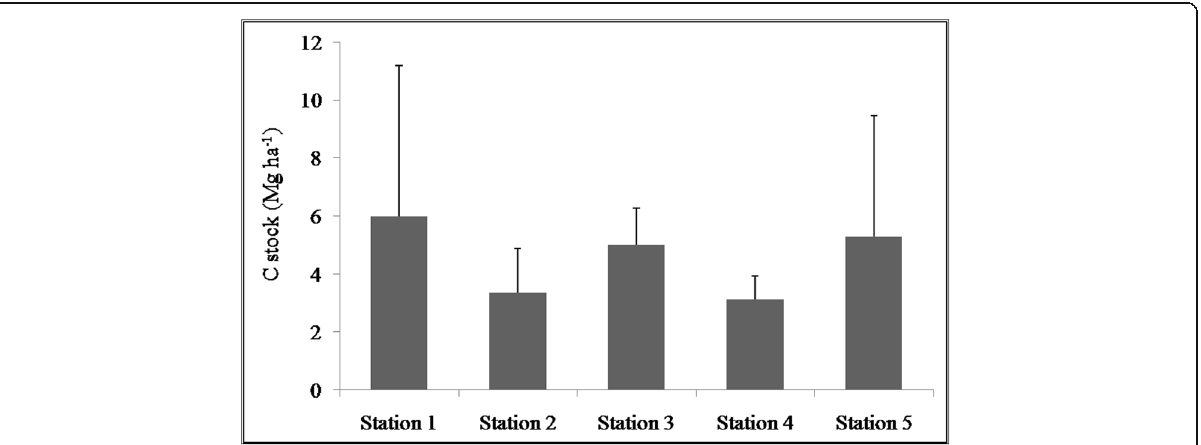
Fig. 6 Carbon stock (Mg ha − 1 ) of wetland vegetation across the different sampling stations namely station 1, inlet point 1; station 2, middle point